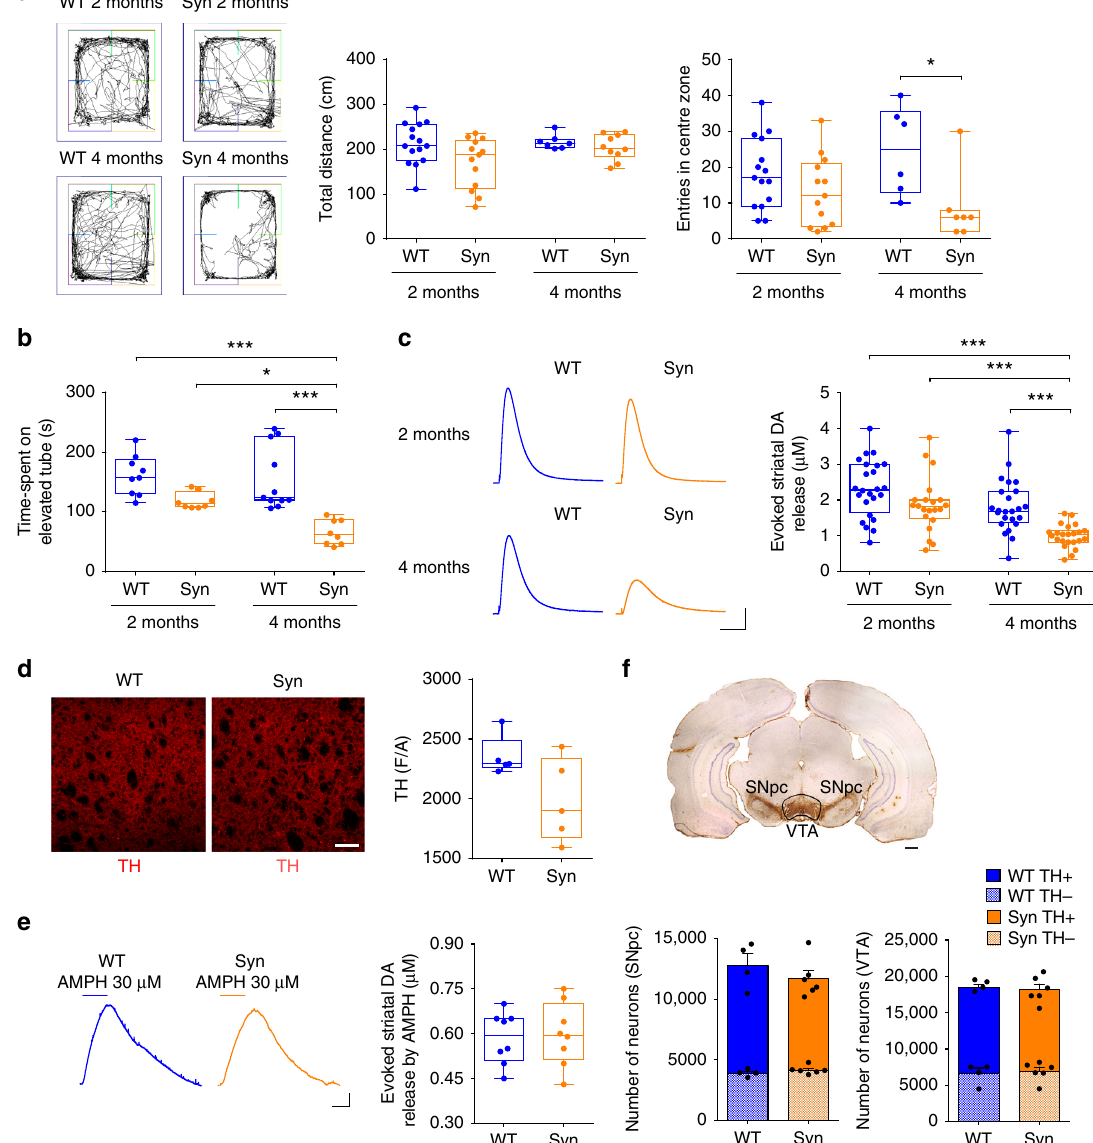
Fig. 1 Motor de fi cits and reduced striatal DA in 4-month-old Syn rats. a Distance travelled during open fi eld test (2-month-old: 15 WT, 13 Syn;